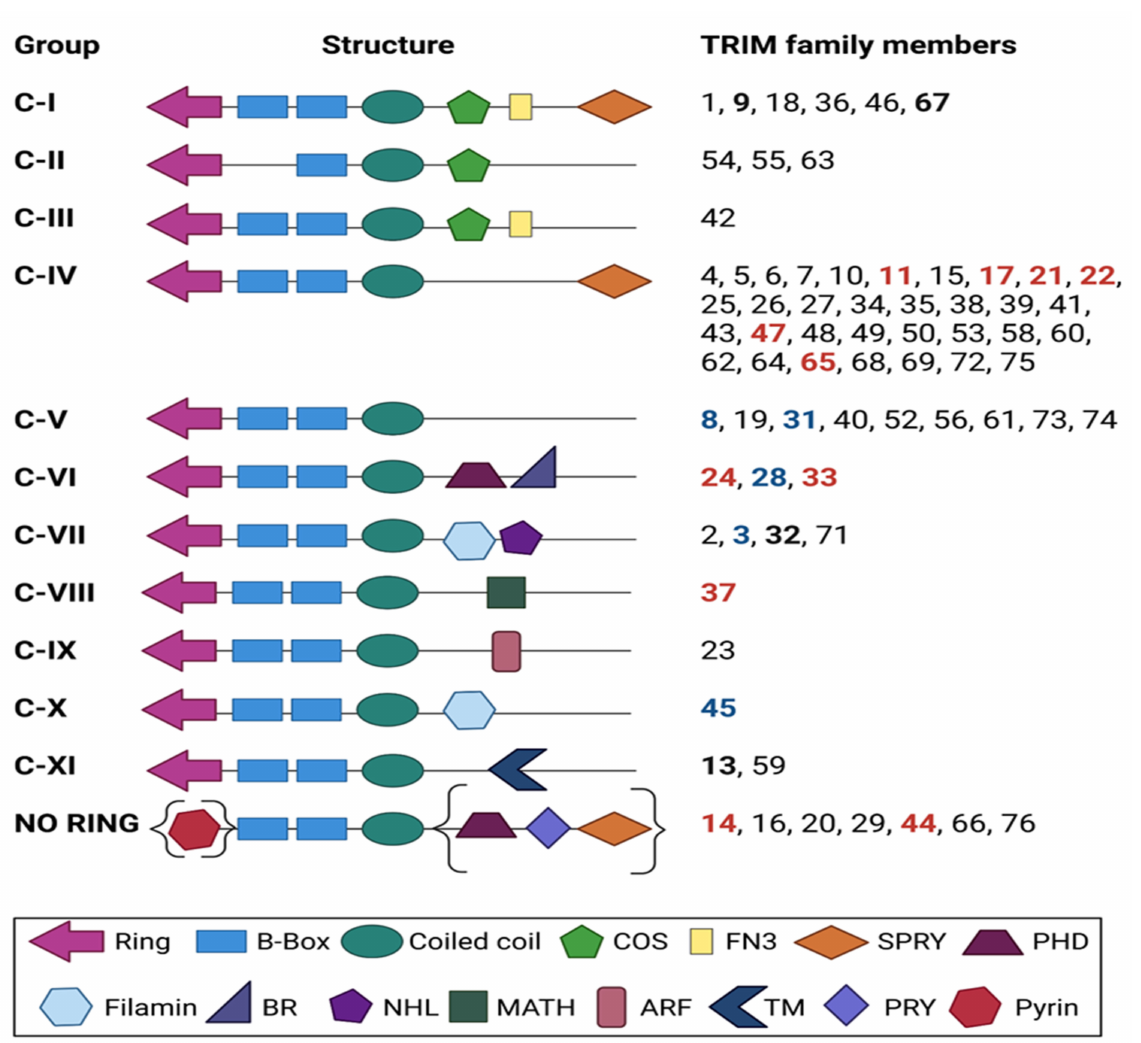
Figure 1. Classification of human TRIM proteins based on the nature of their C-terminal domains. The TRIM protein family is composed of 11 subfamilies, from CI to CXI, and one unclassified group of RING-less TRIM proteins. Individual proteins involved in brain physiology and tumors are marked with black and red, respectively, while the ones reported in both cases are shown in blue (created by BioRender.com